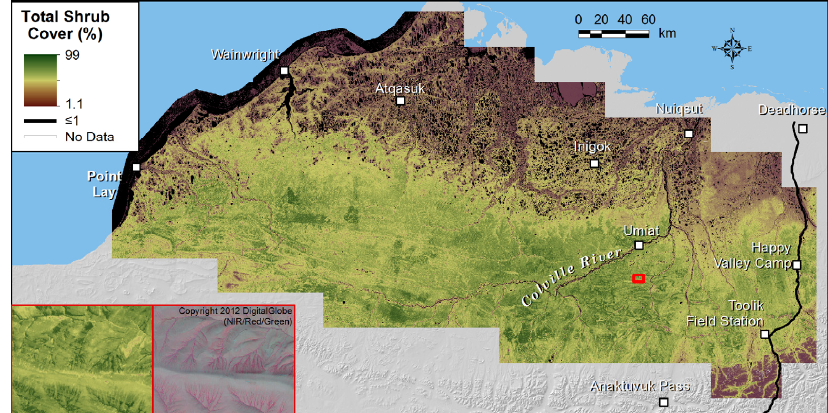
11 of 27 was comparable in a variety of landscape positions on the coastal plain, such as drained lake basins and meandering floodplains (32.3%; SD 8.7) (Figure 8). The predicted total cover of nonvascular plants was very similar between the foothills (53.8%; SD 9.5) and the coastal plain (49.4%; SD 17.6) (Figure 9). Table 4. Model performance metrics for cover models using full set of 78 predictors, based on internal cross-validation, North Slope, Alaska. Plant Functional Type